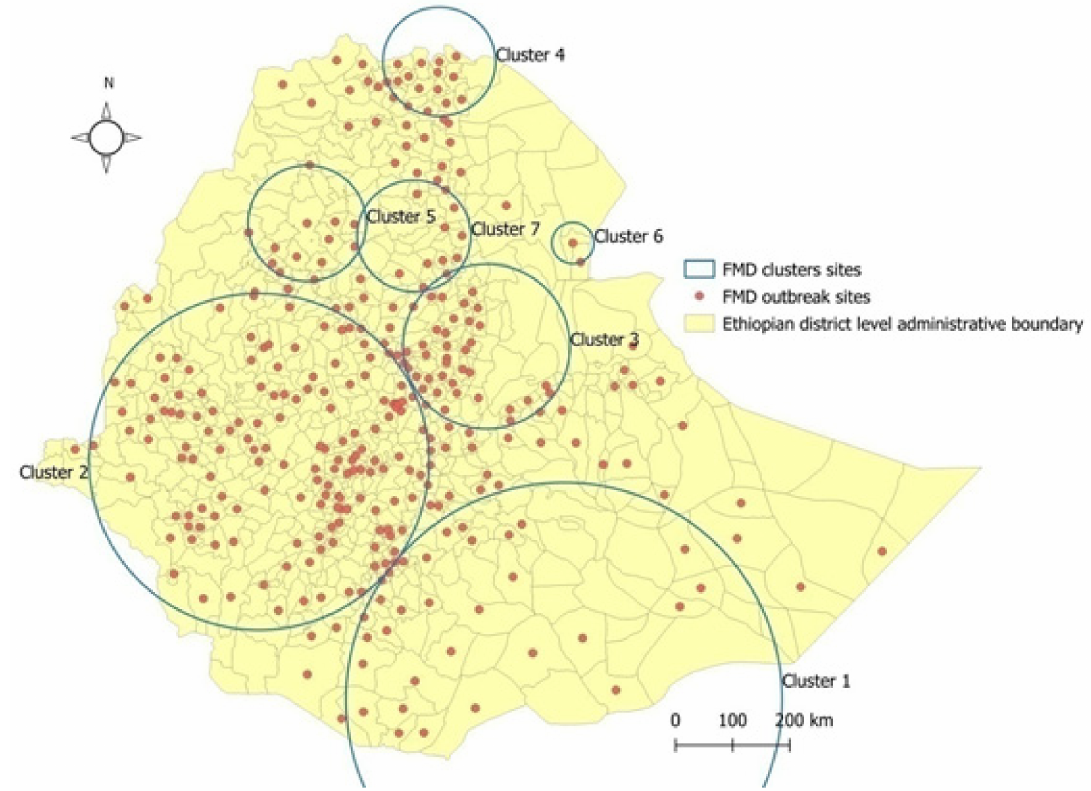
Figure 7. Map showing the Federal Democratic Republic of Ethiopia as of February 2022. The grey lines in the map indicate the district level administrative divisions. Included is the SaTScan cluster analysis of FMD outbreaks from 2010 to 2019 in Ethiopia (50% at risk). The red dots are outbreak spots and the light blue circles are clusters. Cluster 1: 1 January 2017 to 31 December 2019; Cluster